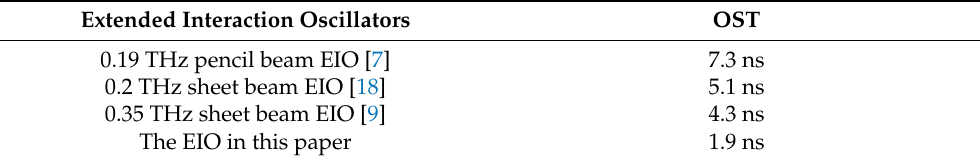
Table 2. The OST of different EIOs.